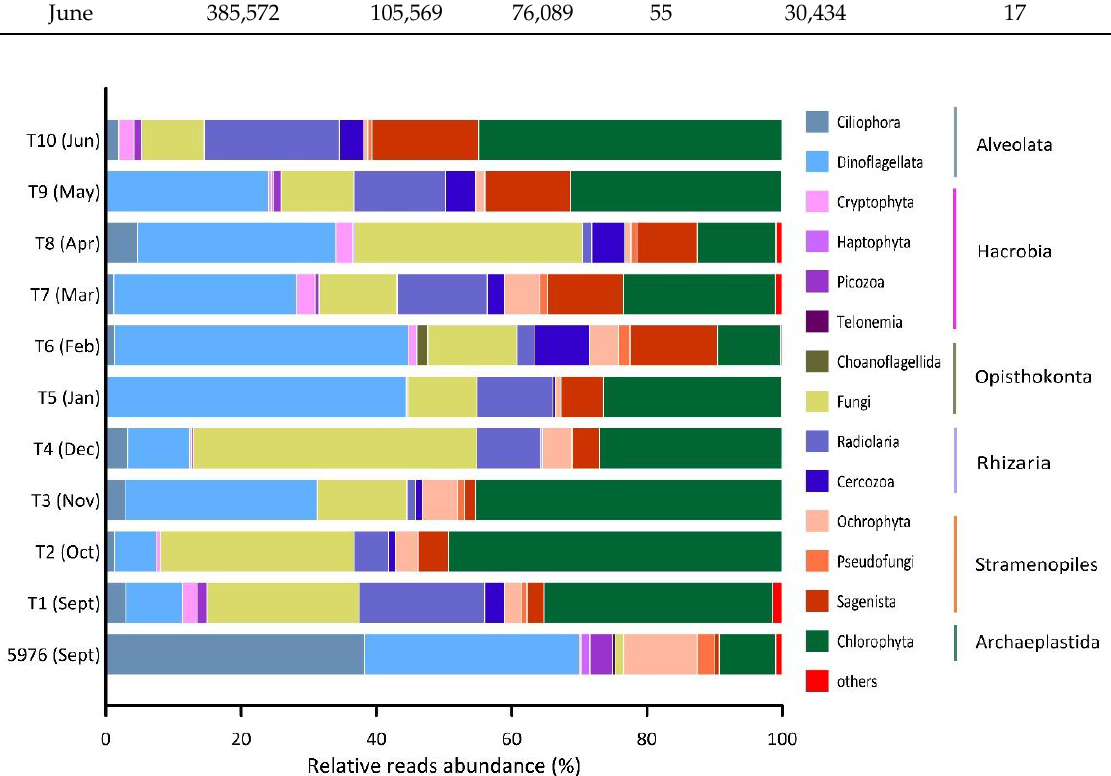
Figure 4. Relative reads abundance (%) of the major taxonomic groups in the studied samples. “Others” includes groups with the contribution <1% (Apicomplexa, Perkinsea, Conosa, Centroheliozoa, Mesomycetozoa, Opalozoa).